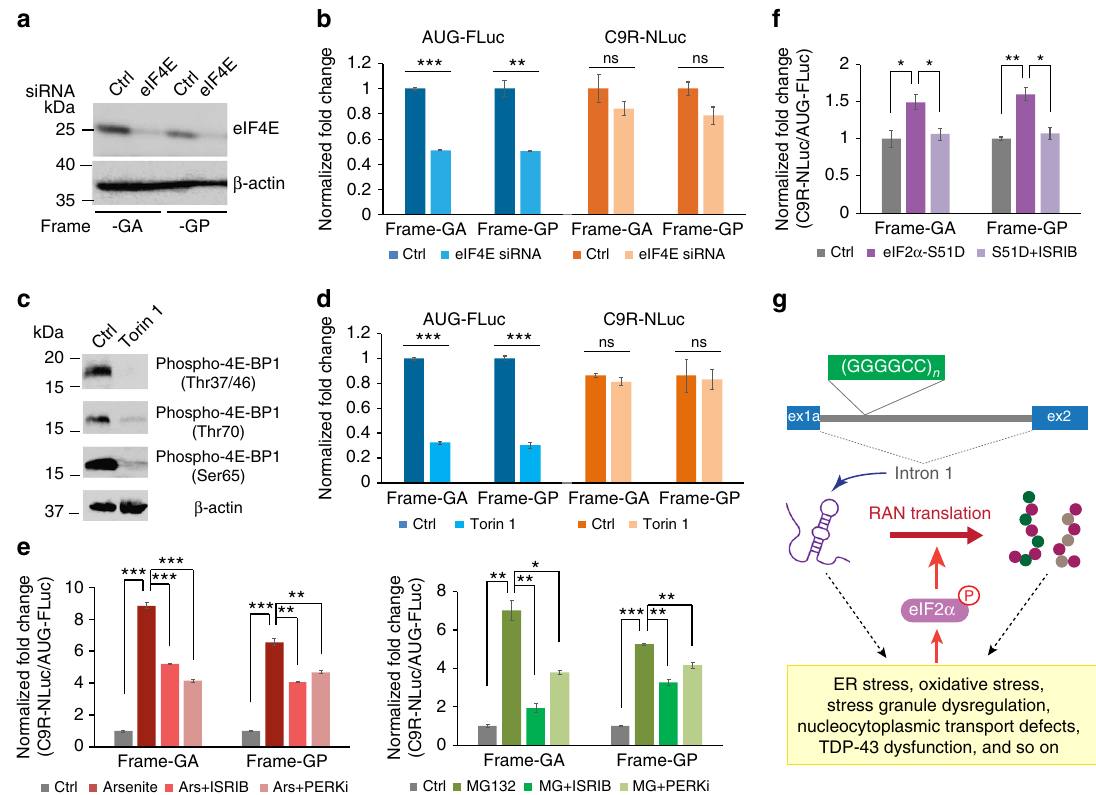
Fig. 6 Translation of intronic repeats does not require 5 ′ -cap and can be upregulated by stress. a HeLa reporter cells were transfected with non-targeting siRNA or siRNA against cap-binding protein eIF4E. Immunoblotting of eIF4E showed the knockdown ef fi ciency. β -actin was blotted as internal control. b Expression of AUG-FLuc translation (left) and C9R-NLuc RAN translation (right) reporters in presence of non-targeting siRNA or siRNA against eIF4E. ** P < 0.005, *** P < 0.0005, two-tailed t- test. c Bicistronic splicing reporter cells were treated with mTOR inhibitor Torin 1 for 24 h. Immunoblotting of phospho-4E-BP1 using antibodies recognizing different phosphorylation sites. β -actin was blotted as internal control. d Expression of AUG-FLuc and C9R- NLuc in bicistronic splicing reporter cells with the treatment of mTOR inhibitor Torin 1. ** P < 0.005, *** P < 0.0005, two-tailed t -test. e Fold change of relative RAN translation vs. AUG translation of the bicistronic splicing reporters under arsenite (left) and MG132 (right) stimuli, without or with pretreatment of ISRIB or PERKi. NLuc signals were normalized to FLuc in each sample. * P < 0.05, ** P < 0.005, *** P < 0.0001, two-tailed t -test. f Fold change of RAN translation upon eIF2 α -S51D expression, without or with the treatment of ISRIB. * P < 0.05, ** P < 0.005, two-tailed t -test. g Diagram for a feedforward loop with C9ORF72 (GGGGCC) n RAN translation being enhanced by initial repeat-mediated toxicity through eIF2 α phosphorylation pathway. Data are mean ± SEM from three biological